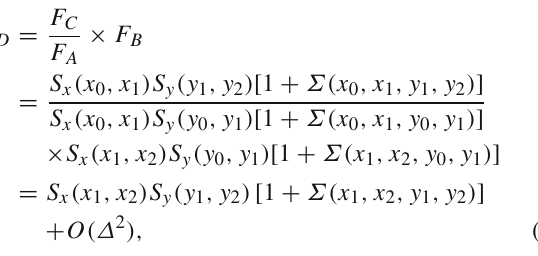
The information from the three A , B , and C CRs, is used to estimate the backgrounds in the signal region, D (Fig.